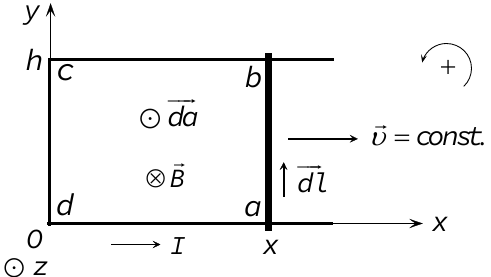
Figure 5: A metal bar ( ab ) sliding on two parallel rails that form part of a U-shaped wire.